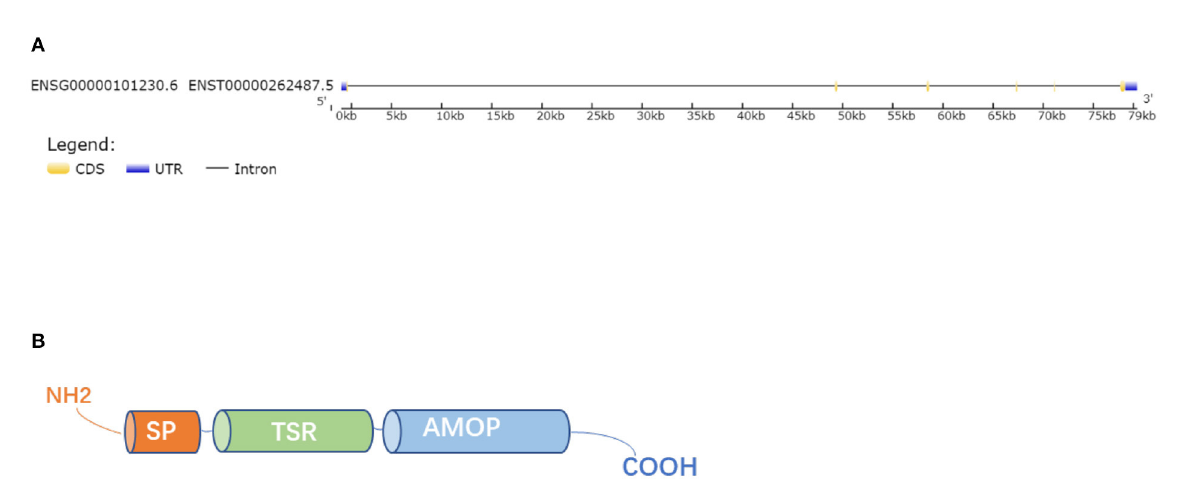
FIGURE1 Gene and protein structure. (A) The gene structure of ISM1. (B) The whole ISM1 protein was composed of an amino (N)-terminal signal peptide (SP), a TSR domain and a conserved C-terminal AMOP